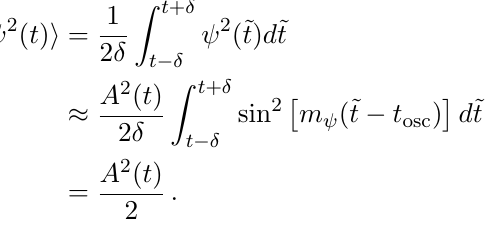
Figure 22. Log-log plot of X (cid:12)gure 20 from the scan of 50 million sets of initial conditions. The quantity X degree of (cid:12)ne-tuning required to achieve the associated value of the B - L